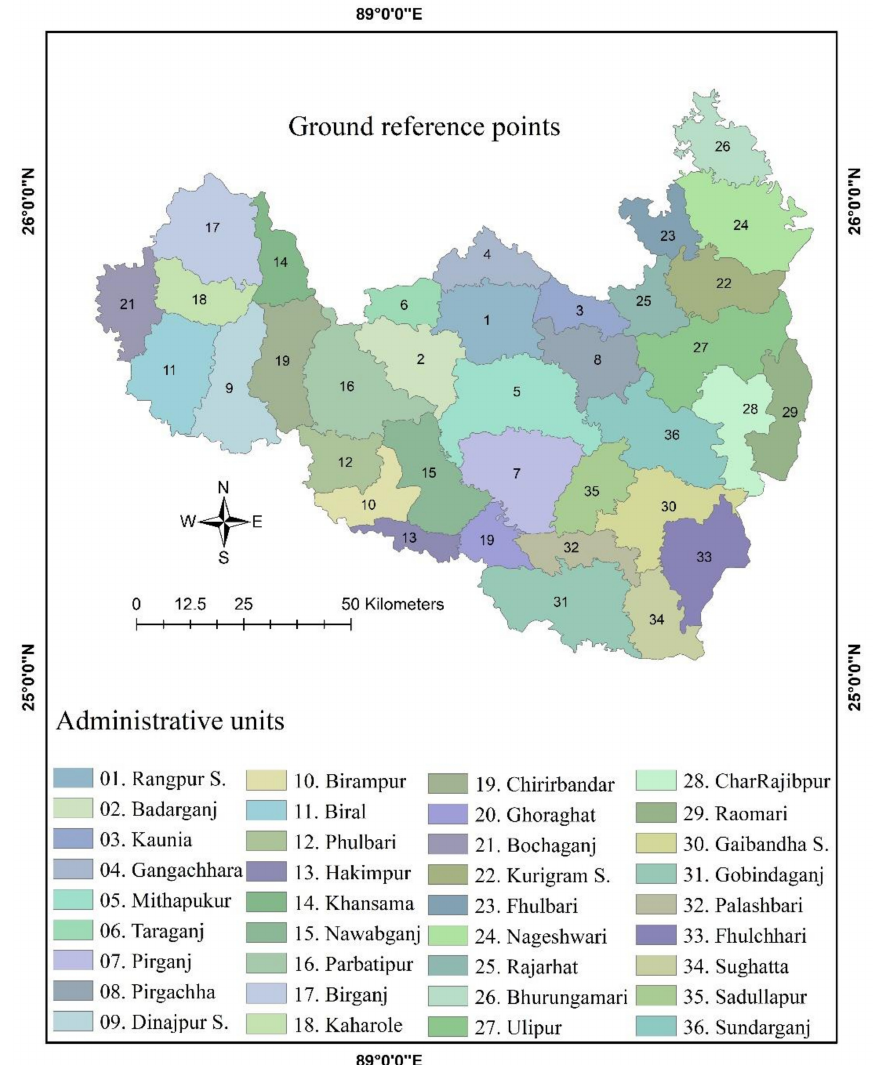
Figure 4. Ground Reference information points in 36